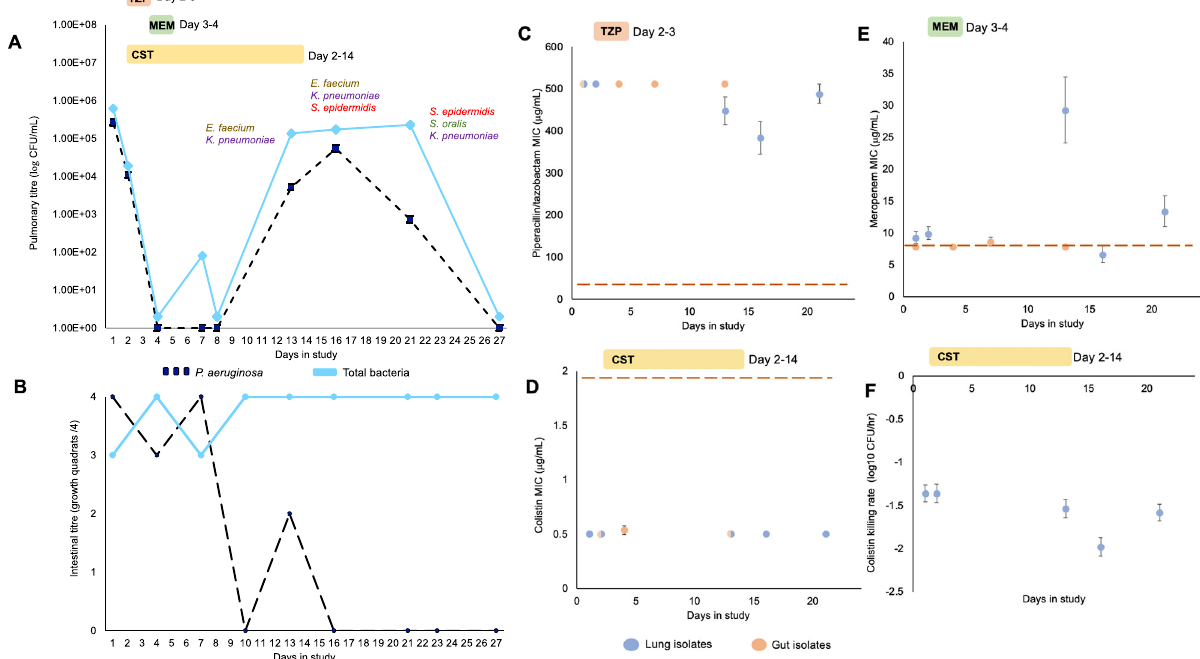
Fig. 1 Clinical timeline and resistance phenotyping. A Bacterial abundance in the lung was assessed by plating out samples of endotracheal aspirate (ETA) on Pseudomonas selective agar (dark blue) and blood agar (total titer, light blue). Rank-order species abundance data is shown for the total bacterial counts. B Bacterial abundance in the gut was assessed on a nominal scale by streaking peri-anal swabs on Pseudomonas selective agar and blood agar (total titer). Day 1 in study is 72 h after ICU admission and corresponds to the fi rst day of patient informed consent. The patient received intravenous treatment with piperacillin/tazobactam (TZP: 4 g/0.5 g IV q8h), meropenem (MEM1: g IV q8h) and colistin (CST 3 million IU IV q8h). Panels C – E show the mean MIC of lung (blue) and intestinal (beige) isolates, as determined by broth microdilution ( + / − s.e.m; n = 11 or 12 isolates). Red dashed lines represent the EUCAST clinical breakpoint (01/01/2019 edition). Panel F shows the mean rate of change in viable cell titer of lung isolates following treatment with 2 mg/L of colistin ( + / − s.e.m; n = 10-12 isolates). Source data are provided as a Source Data fi